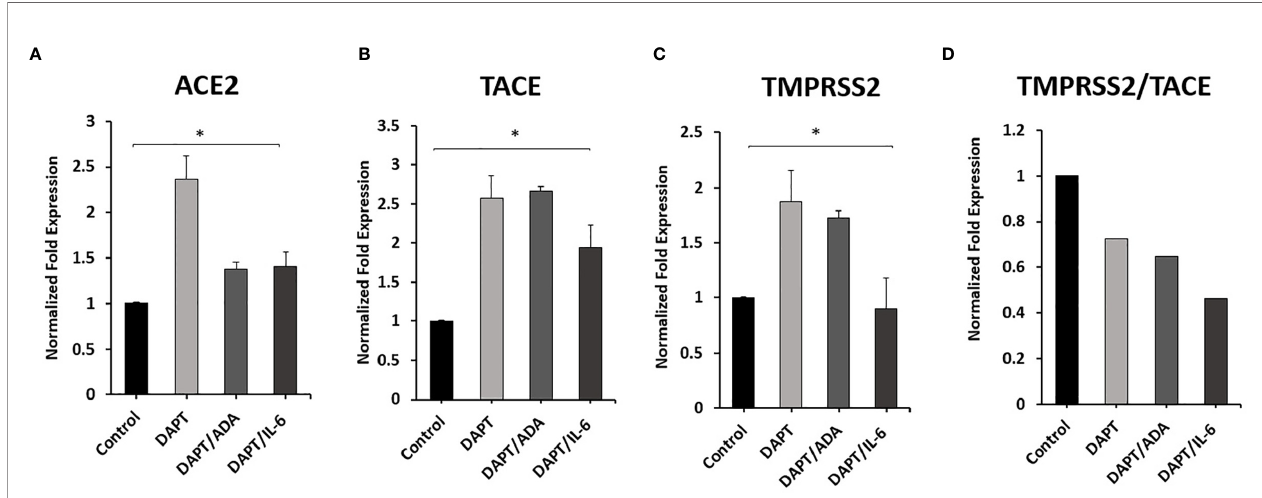
FIGURE 6 | Effect of anti-TNF- a and rIL-6 on ACE2, TACE, and TMPRSS2 Expression in DAPT pretreated Macrophages. THP-1 derived macrophages were pre- treated with DAPT (30 m M for 24 h) and then treated with non-PEGylated anti-TNF- a (ADA; 40 m g/ml) and rIL-6 (500 U/ml). The expression levels of (A) ACE2, (B) TACE, and (C) TMPRSS2 were detected by RT-PCR. (D) The ratio between TMPRSS2 and TACE. All experiments were performed in triplets. Data are shown as mean ± SD, and signi fi cance is considered as *P < 0.05.